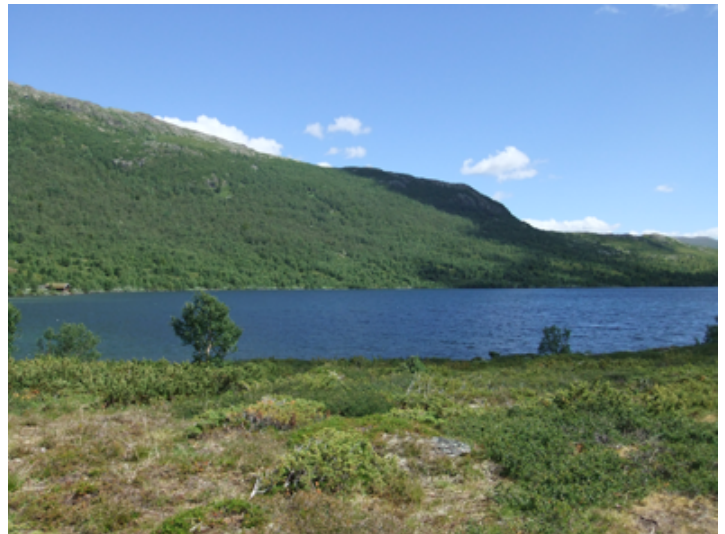
Figure 1. Experimental group and nature control group picture used in Study 1.